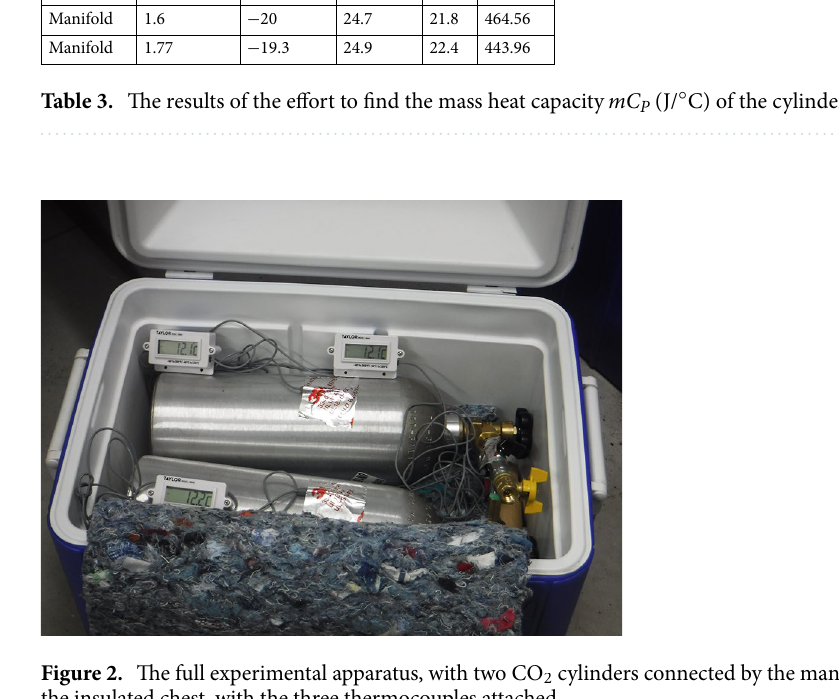
Figure 2. The full experimental apparatus, with two CO 2 cylinders connected by the manifold (Fig. 1), inside the insulated chest, with the three thermocouples